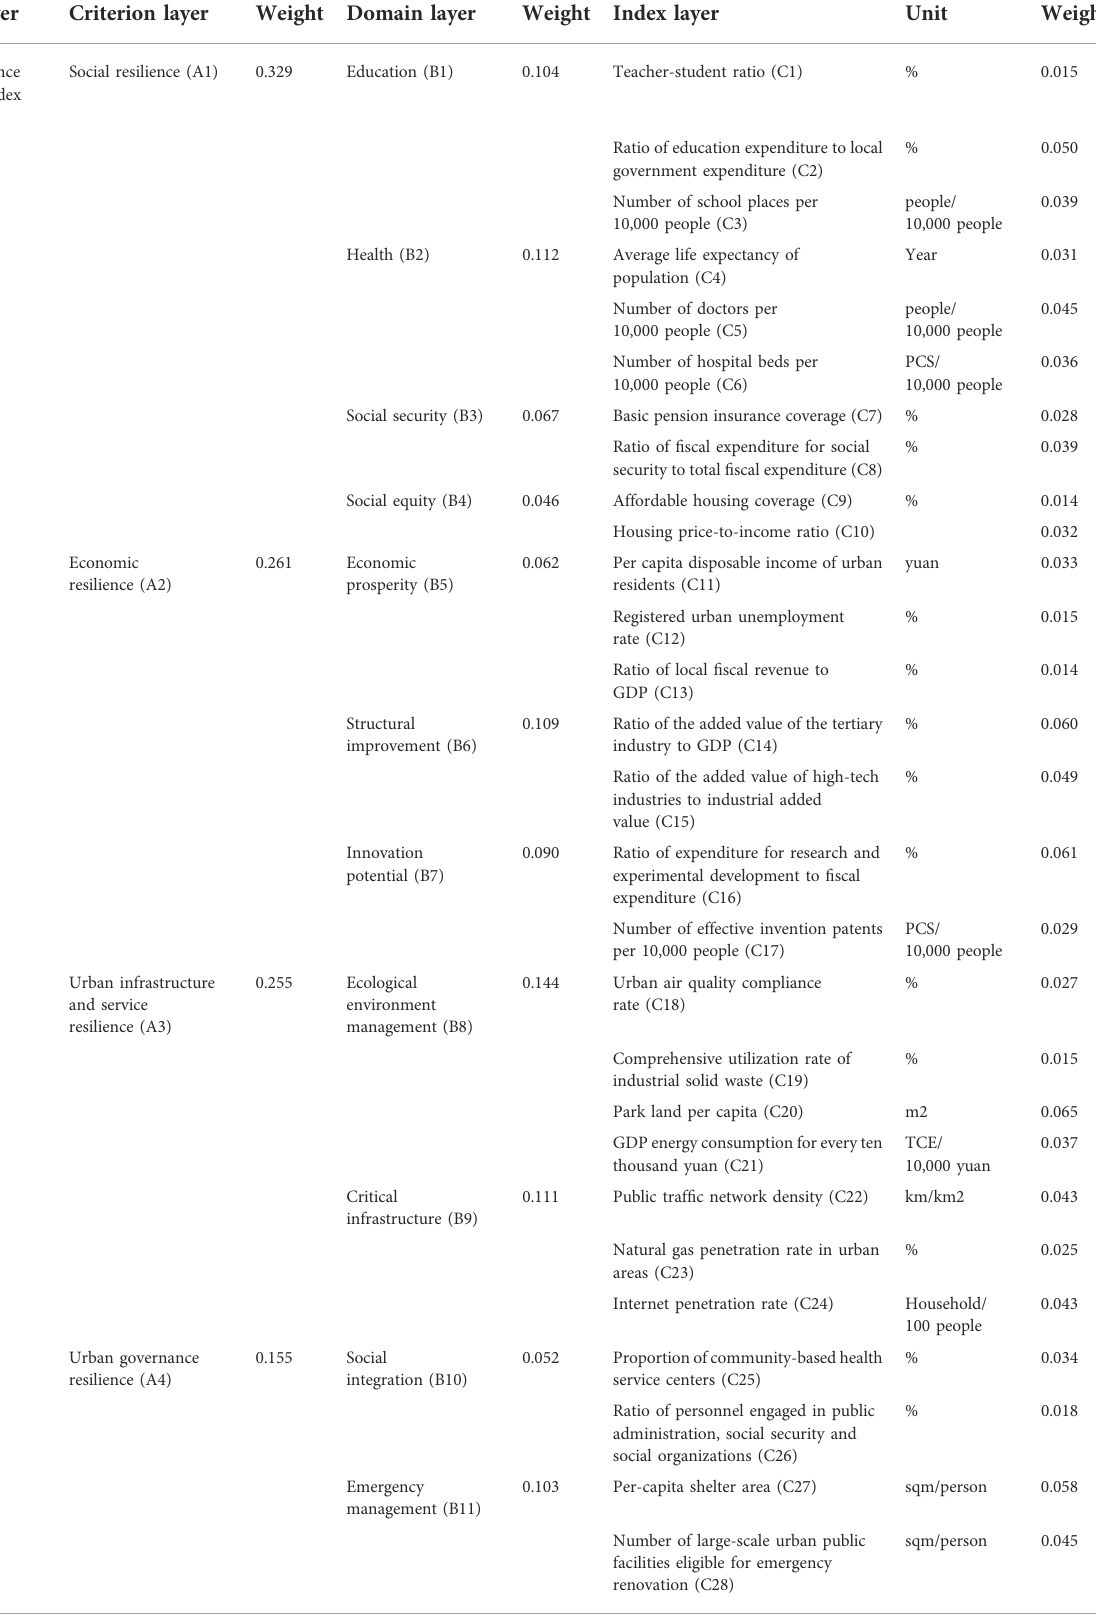
TABLE 1 Comprehensive weight table of urban resilience evaluation